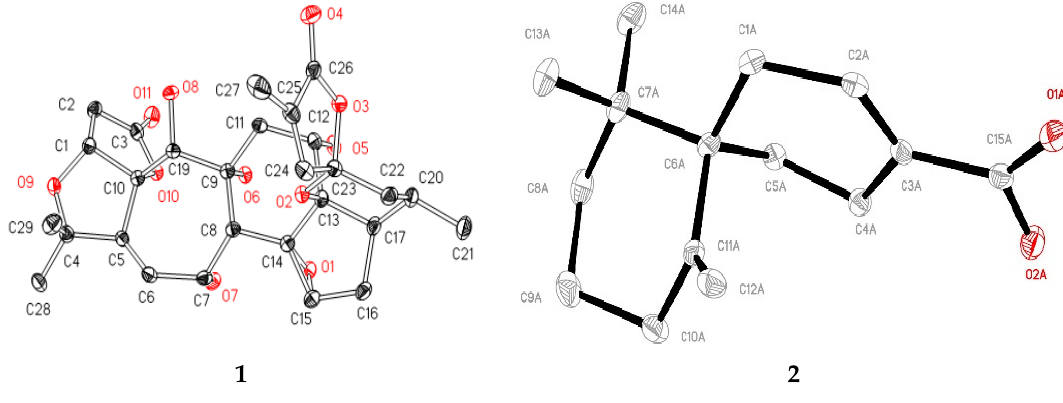
Figure 3. X-ray crystal structures of 1 and 2 .